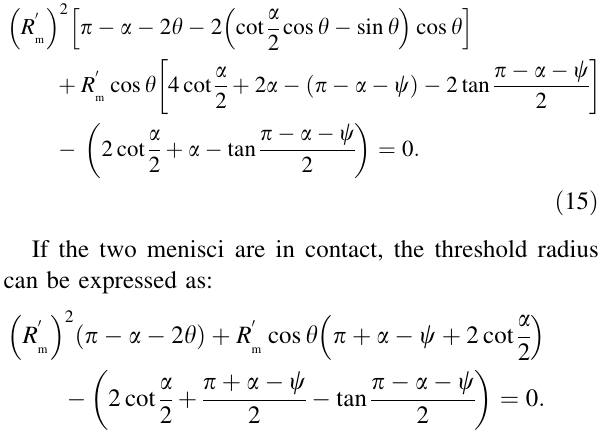
Fig. 10 Wetting phase saturation, S , for different angles between